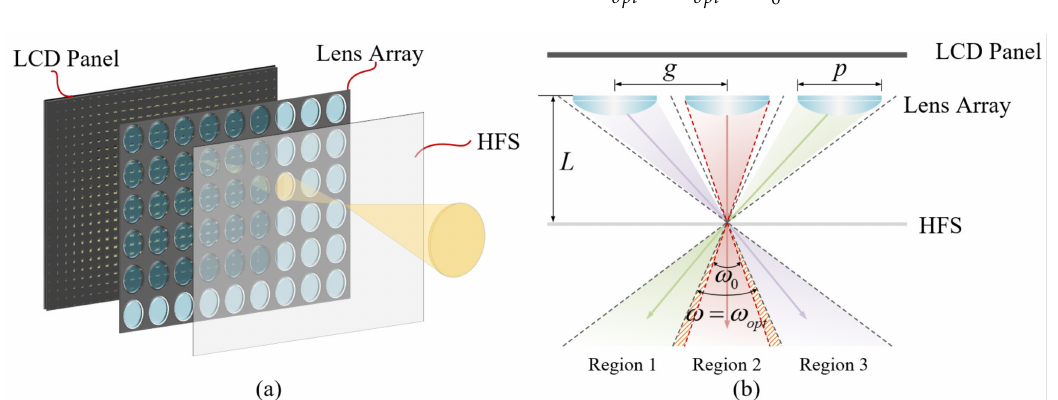
Figure 3. Schematic diagrams of the display principle: ( a ) the light modulation process using the lens array and the HFS; and ( b ) the relationship between the diffusion angle of the HFS and the lens